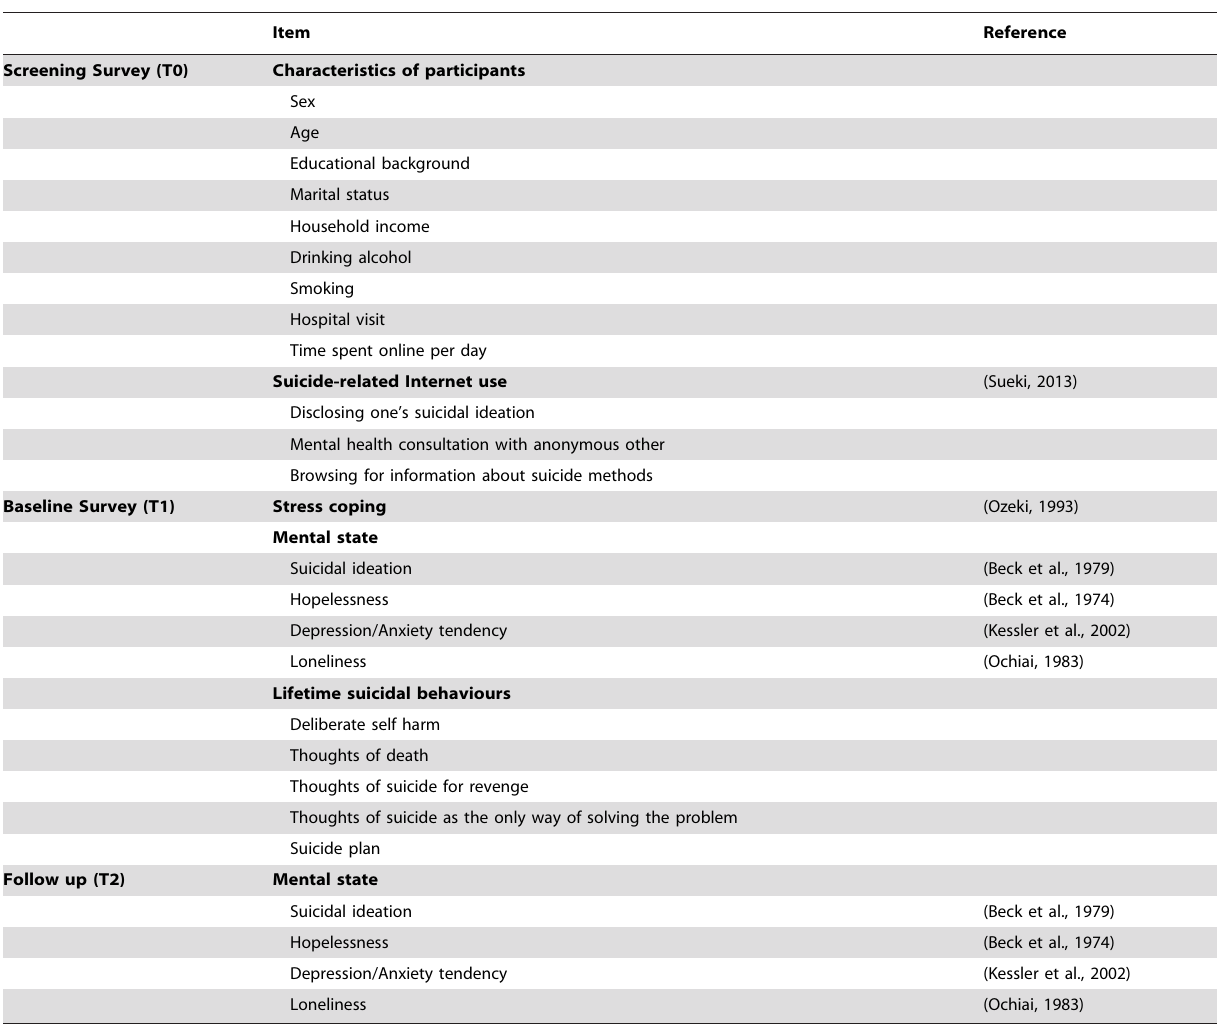
Table 1. List of the survey items at T0, T1, and T2.